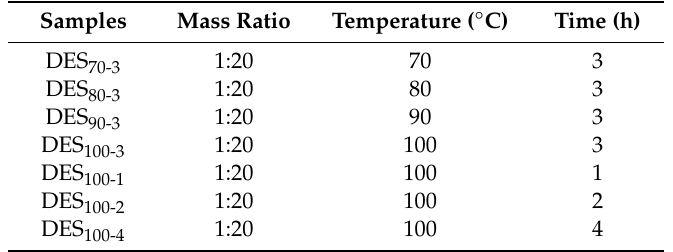
Table 1. Conditions during the deep eutectic solvent (DES) treatment of chitin. Samples Mass Ratio Temperature ( ◦ C) Time (h) DES 70-3 1:20 70 DES 80-3 1:20 80 DES 90-3 1:20 DES 100-3